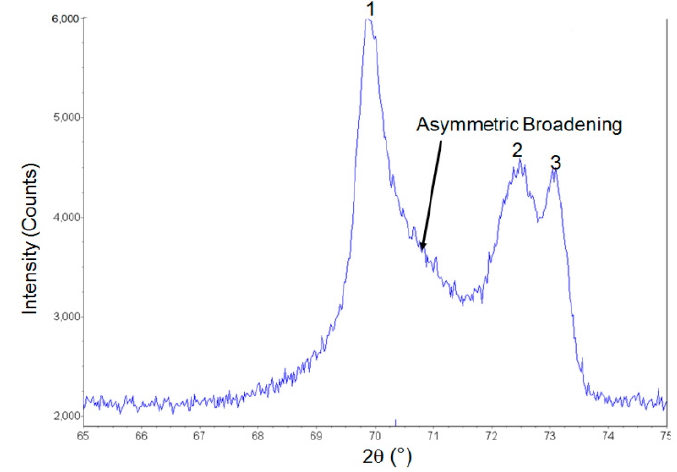
Figure 1. Magnified view (65 ˝ < 2 θ < 75 ˝ ) of the measured XRD pattern.